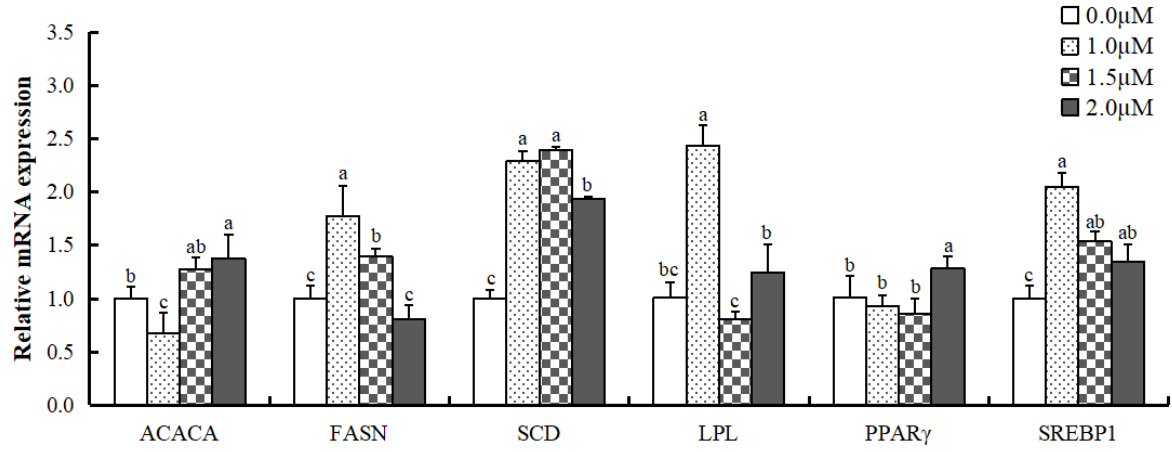
Figure 4. mRNA expression levels of fatty acid synthesis-related genes in differentiated MAC-T cells treated with all-trans retinoic acid. ACACA, acetyl-coA carboxylase 1; FASN, fatty acid synthase; SCD, stearoyl-CoA desaturase; LPL, lipoprotein lipase; PPAR γ , peroxisome proliferator-activated receptor gamma; SREBP1, sterol regulatory element-binding protein 1. Data are mean±standard deviation (n = 3). a-c mRNA levels of the same gene with different superscript letters are significantly different